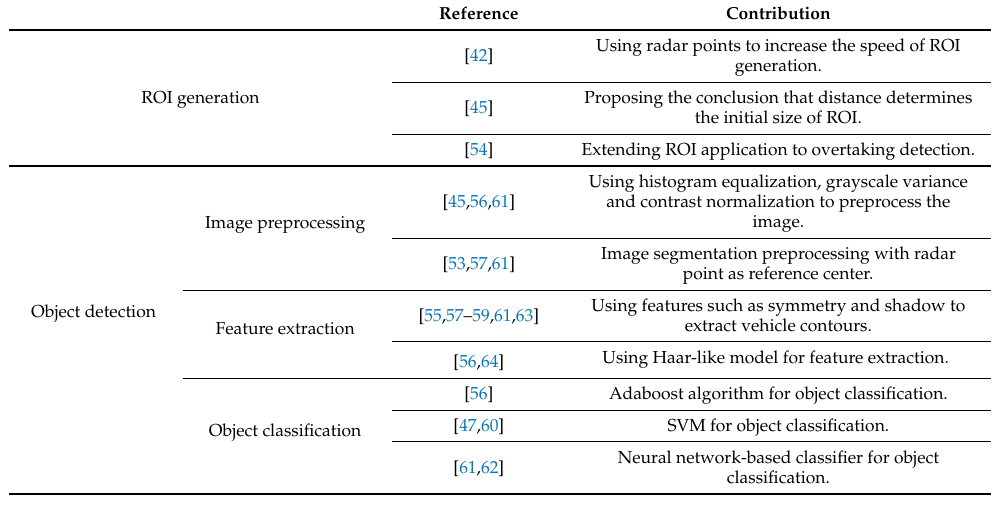
Table 5. Summary of data level fusion.